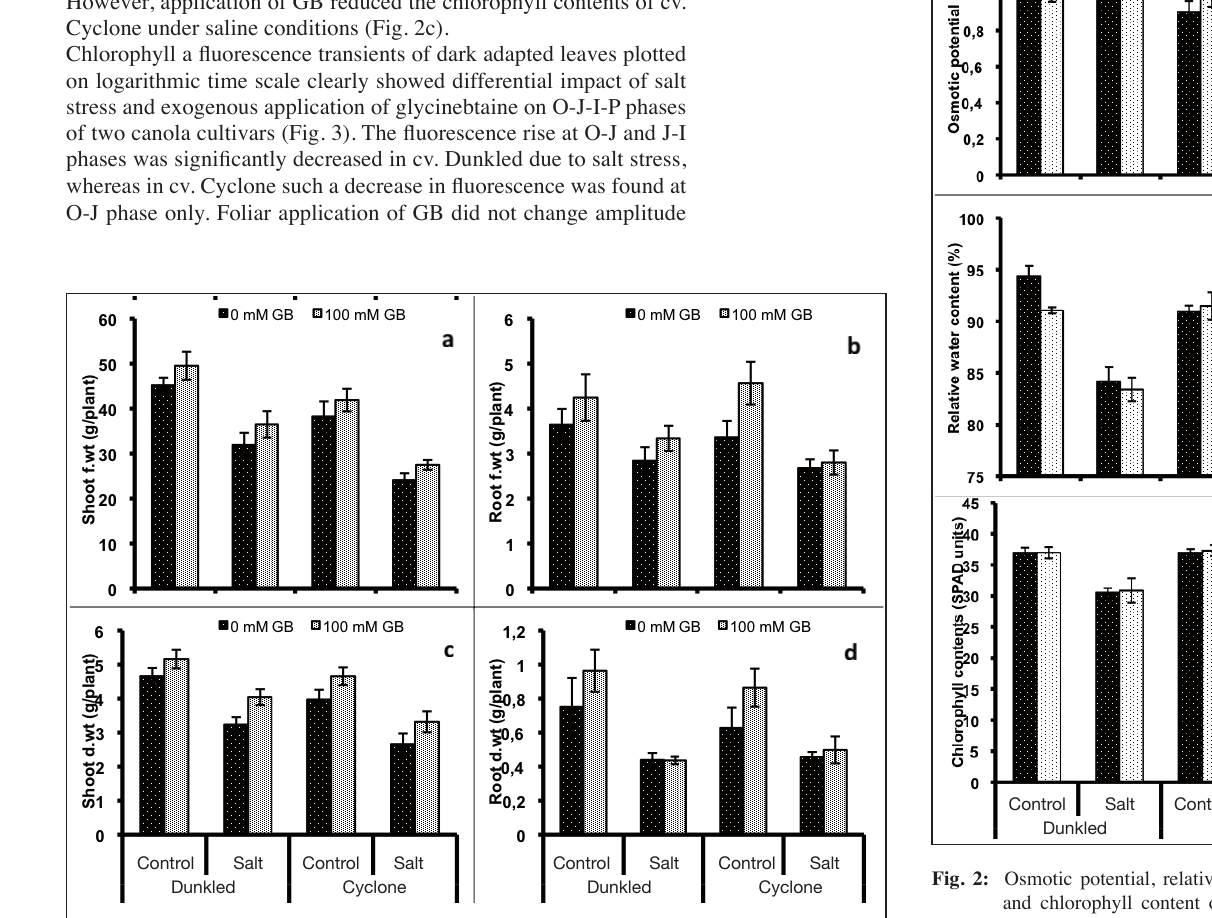
Fig. 1: Shoot and root fresh and dry weight of two cultivars of canola ( Brassica napus L.) when three week old plants were subjected to foliar application of glycinebetaine and salt stress for further two weeks.